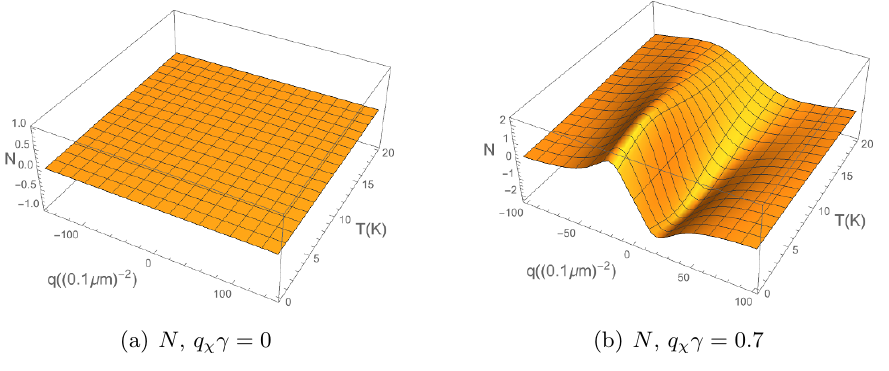
Figure 17 . The temperature and the charge density dependence of Seebeck coe(cid:14)cient without (a) with (b) magnetic impurity. We set (cid:12) 2 = 2747 and v F = 7 : 5 (cid:2) 10 4 m=s . ( (cid:22)m ) 2